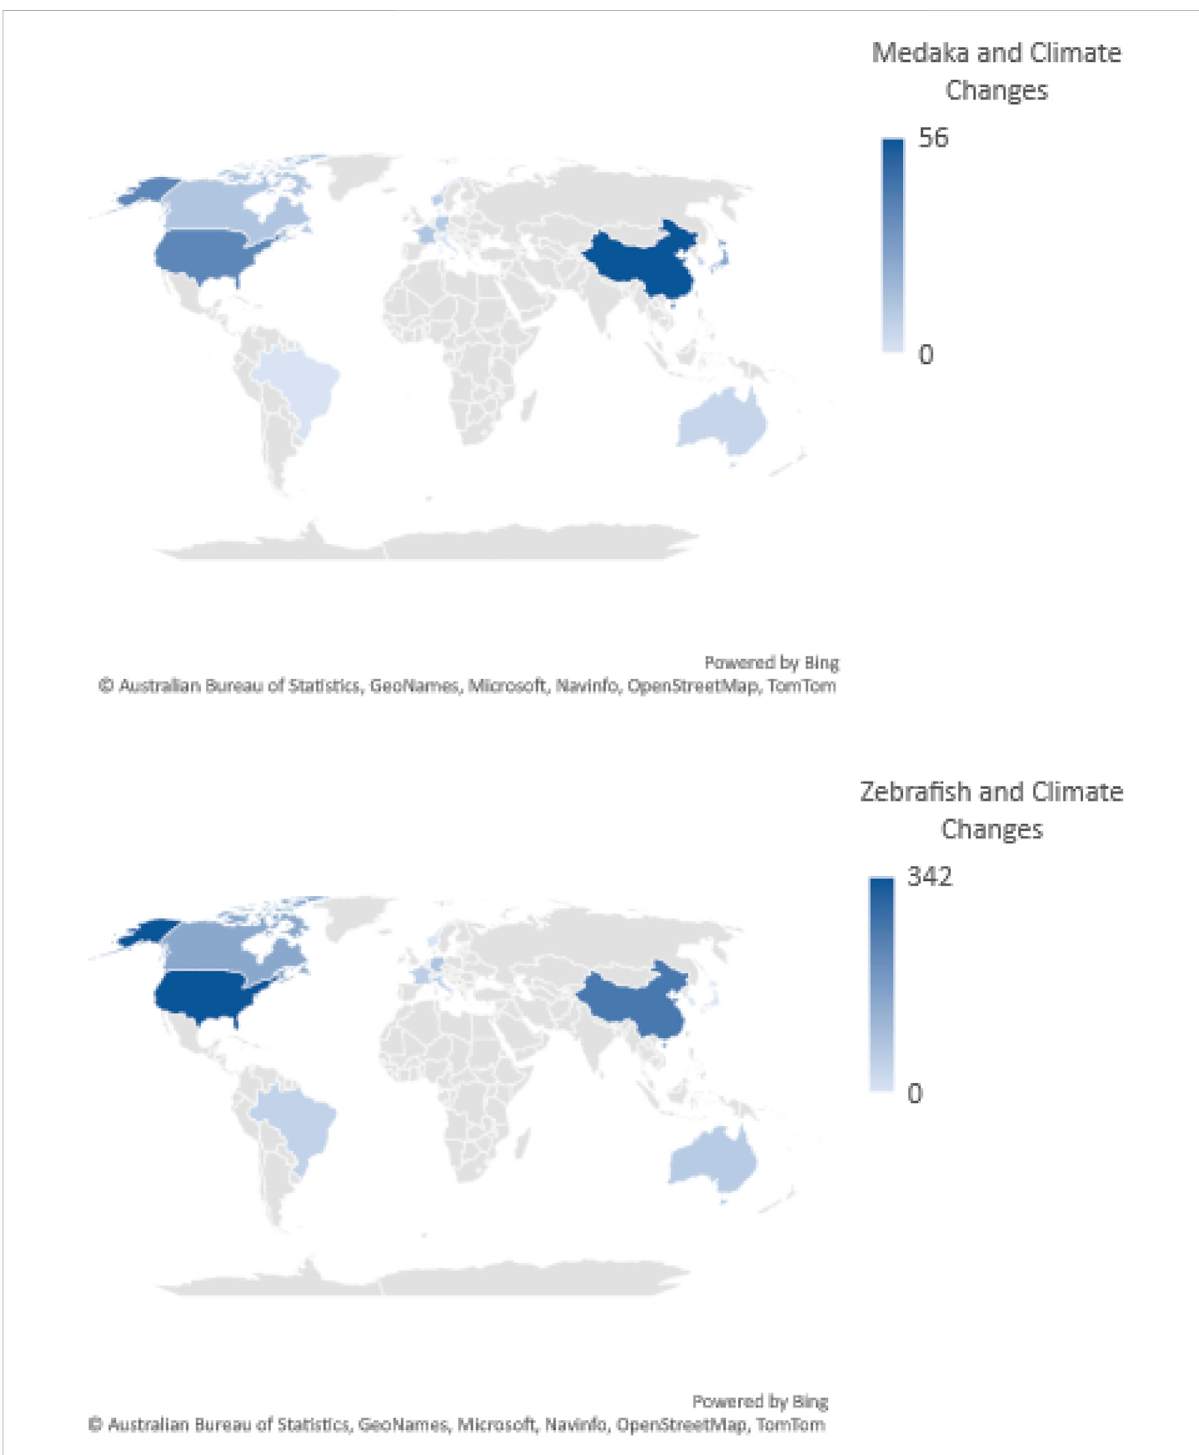
FIGURE 3 The distribution of countries that work on Medaka and Zebra fi sh as a model organism in climate change research and